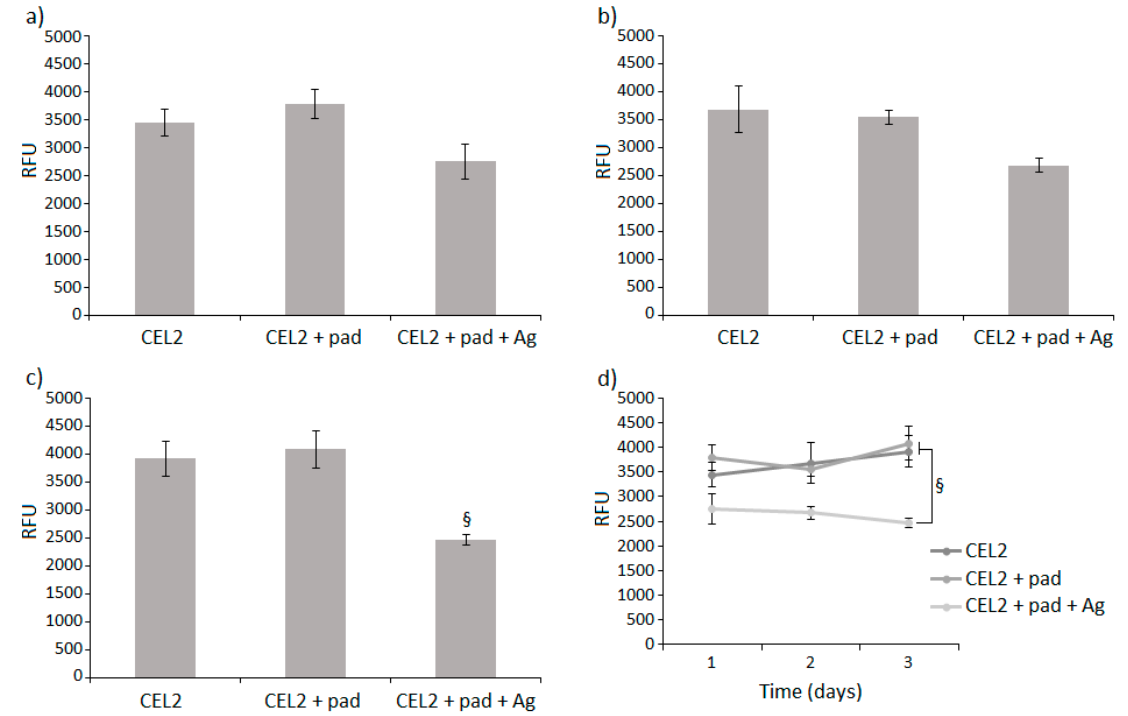
Figure 6. Specimens’ cytocompatibility in direct contact with hFOB cells for ( a ) 24, ( b ) 48, and ( c ) 72 h. The doping with algae extract only (CEL2 + pad) did not introduce any toxic effect, as results were comparable ( p > 0.05) with untreated controls (CEL2). The introduction of silver in combination with extract (CEL2 + pad + Ag) produced a decrease of cells metabolism that was significant after 72 h of cultivation (c, p < 0.05 indicated by the §) in comparison with both CEL2 and CEL2 + pad. ( d ) Accordingly, cells metabolism decreased during the 72 h. (Bars represent means and standard deviations; data are expressed as RFU.